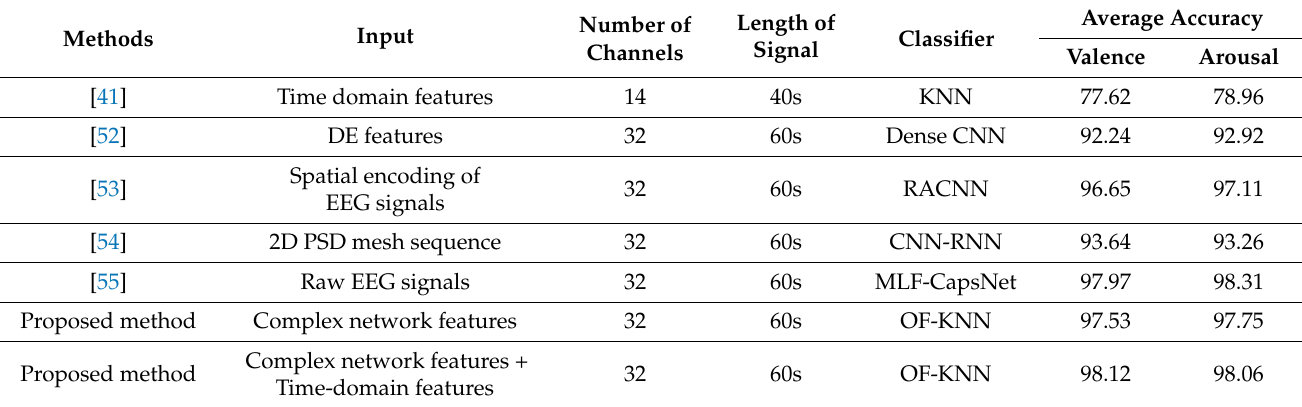
Table 7. Comparison of the proposed work with previous works